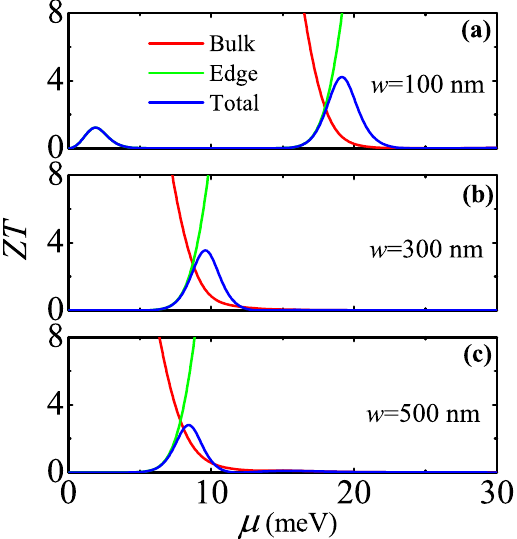
Figure 7. Low-temperature ZT as a function of the chemical potential for various 2D TIs with different ribbon widths: ( a ) w = 100 nm, ( b ) w = 300 nm, and ( c ) w = 500 nm. Here, the black solid (dashed) line represents the edge (bulk) band-edge, the red and green solid lines represent the edge-state and bulk-state contributions to the TE transport, respectively, and the blue solid line represents the total TE transport. The temperature and QW thickness are fixed at T = 10 K and d = 7.5